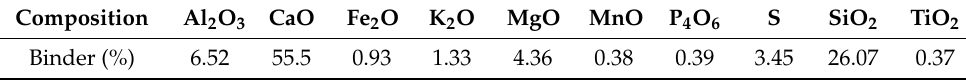
Table 4. Oxide contents in the binder (80% Slag + 20%